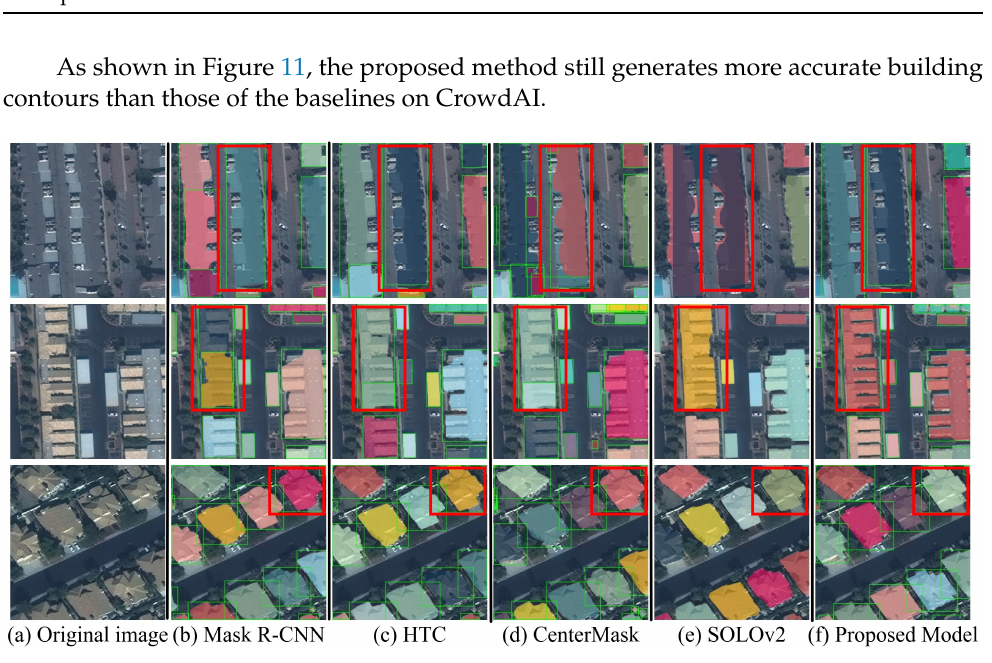
Figure 11. Visualized results of building instance extraction using CrowdAI: ( a ) the original remote sensing imagery, ( b ) Mask R-CNN, ( c ) HTC, ( d ) CenterMask, ( e ) SOLOv2, ( f ) Proposed model.